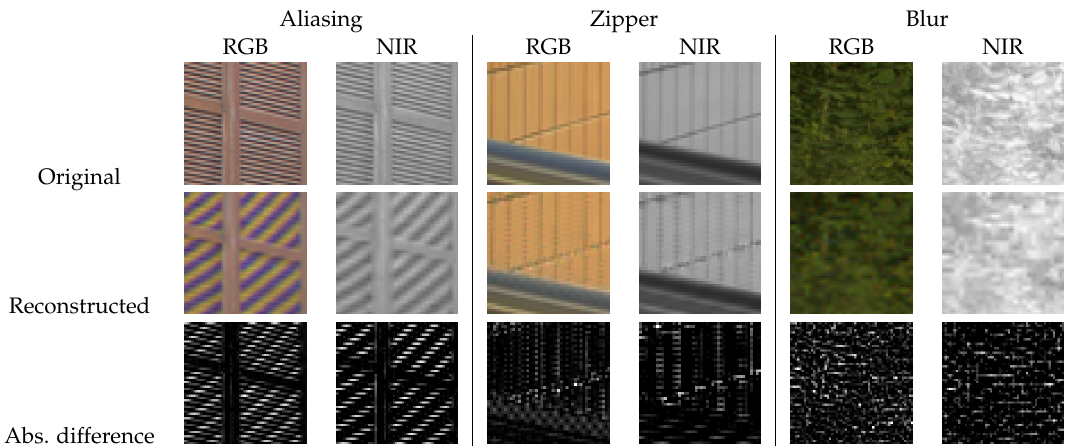
Figure 2. Examples of the most prominent artifacts of demosaicing: aliasing, zipper, and